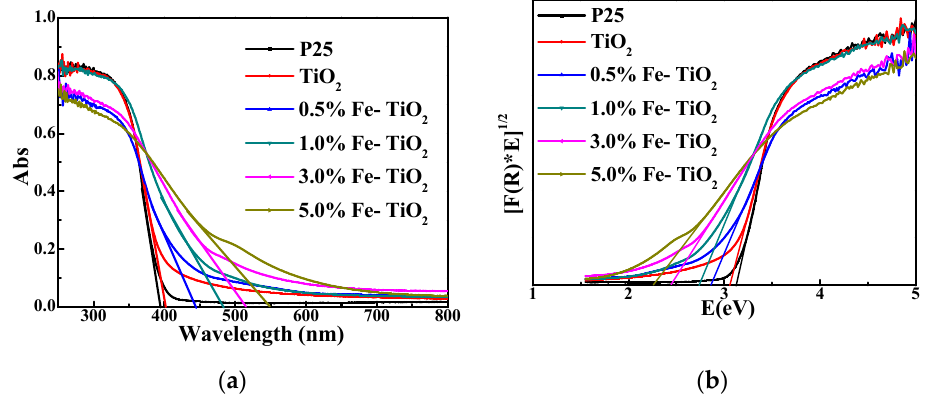
Figure 8. ( a ) UV-vis diffused reflectance spectroscopy (DRS) spectra and ( b ) band gap energies of P25, pure TiO 2 and Fe-TiO 2 .